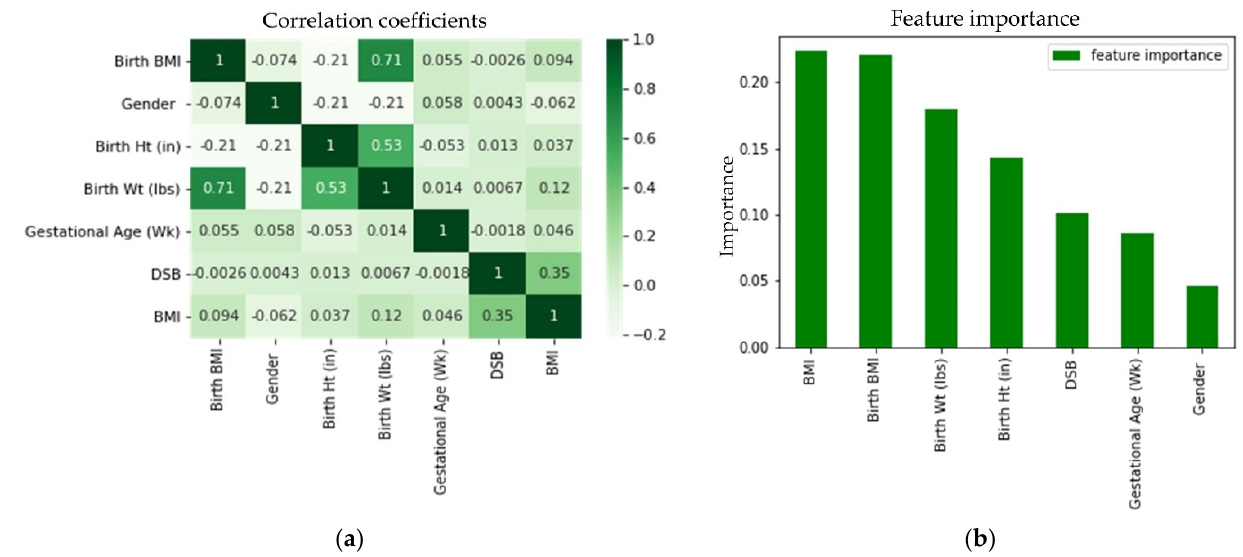
Figure 11. Feature ( a ) correlation coefficient and ( b ) importance for the random forest classifier.